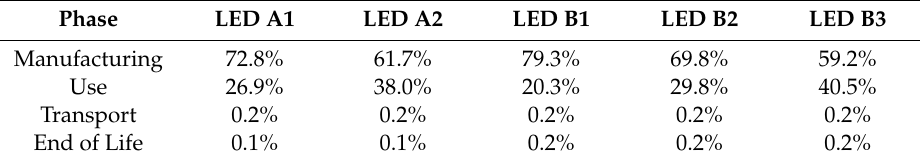
Table 3. Distribution of the potential environmental impacts for each LCA phase.